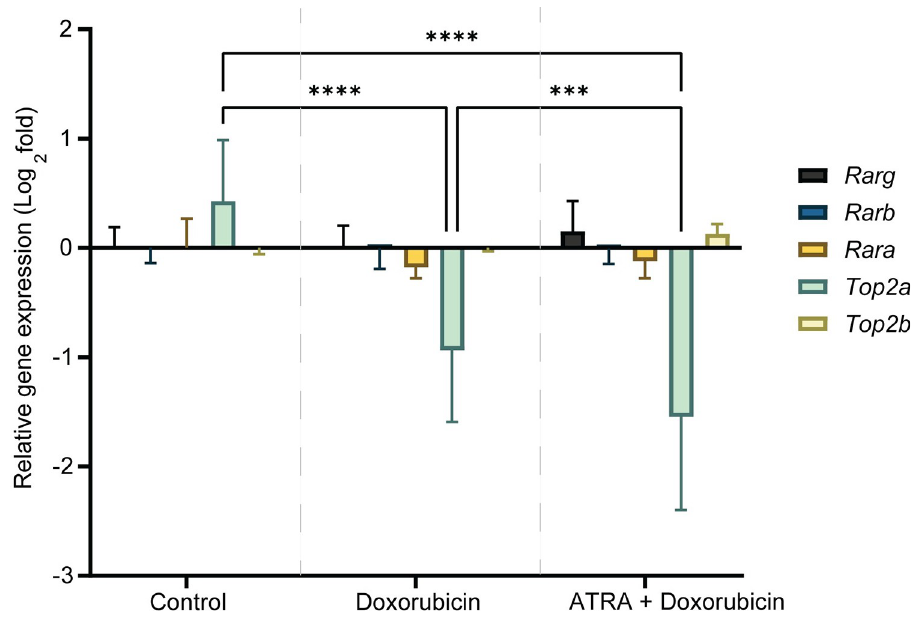
Fig 3. ATRA regulates Top2a gene expression in heart tissues of doxorubicin-treated mice. Fold-change in gene expression of Rarg , Rarb , Rara , Top2a , and Top2b in control (saline-treated), doxorubicin-only treated, and ATRA + doxorubicin-treated mice heart tissues. Data are presented as mean ± standard deviation (N = 9, 3 technical replicates of 3 biological replicates). Statistical analysis was performed using two-way ANOVA and Bonferroni multiple comparisons correction (comparisons between the control vs. doxorubicin, control vs. ATRA + doxorubicin and doxorubicin vs. ATRA + doxorubicin are shown, ��� , and ���� denote P = 0.0009, P < 0.0001, respectively).